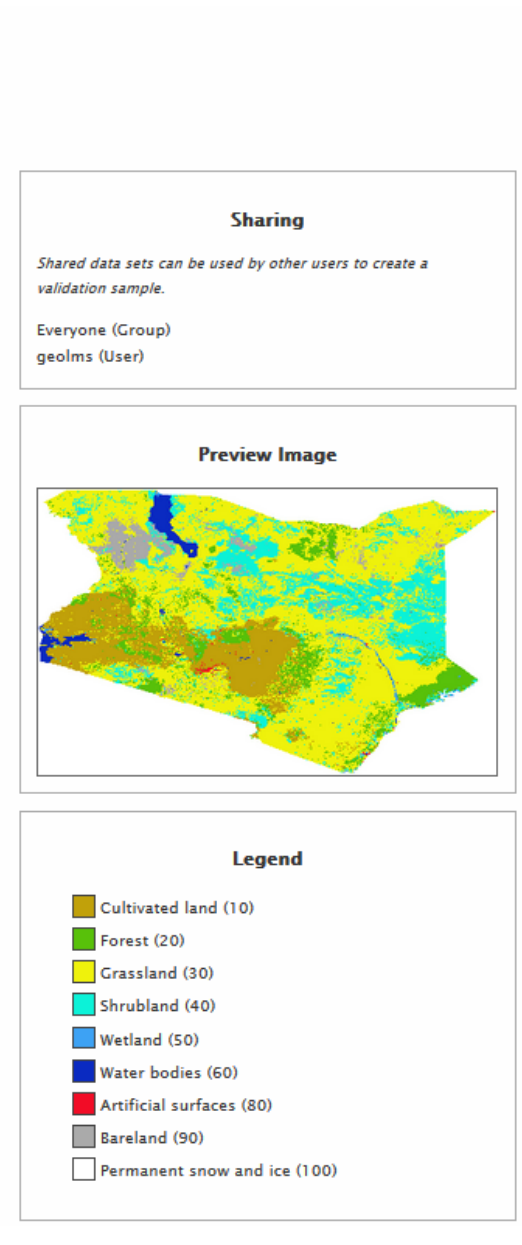
Figure 5. Details of a data set in LACO-Wiki including options to share and preview the data set and to generate a sample.